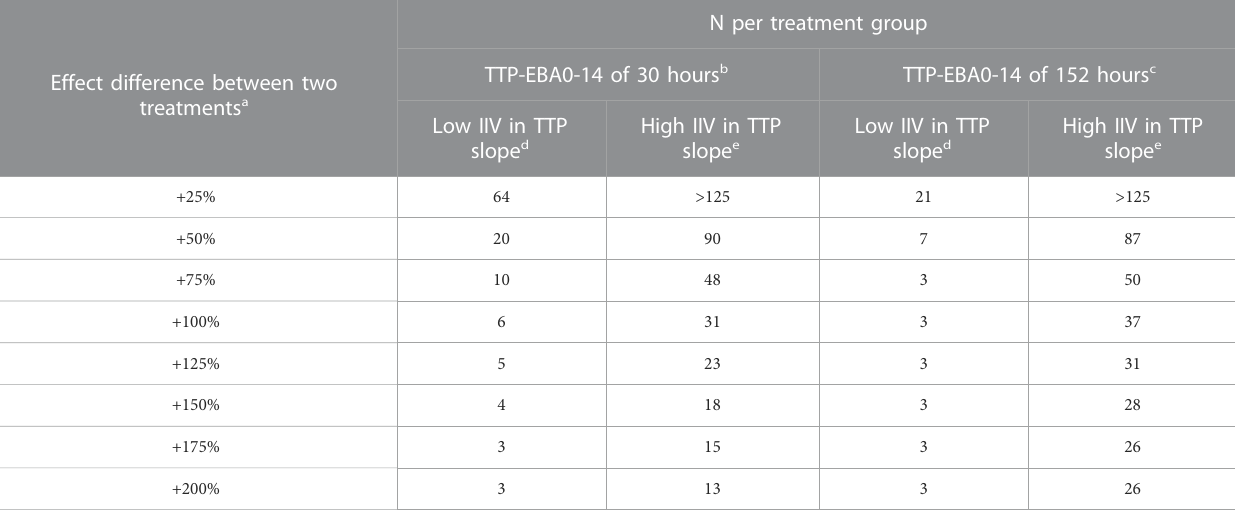
Effect difference between two treatments a